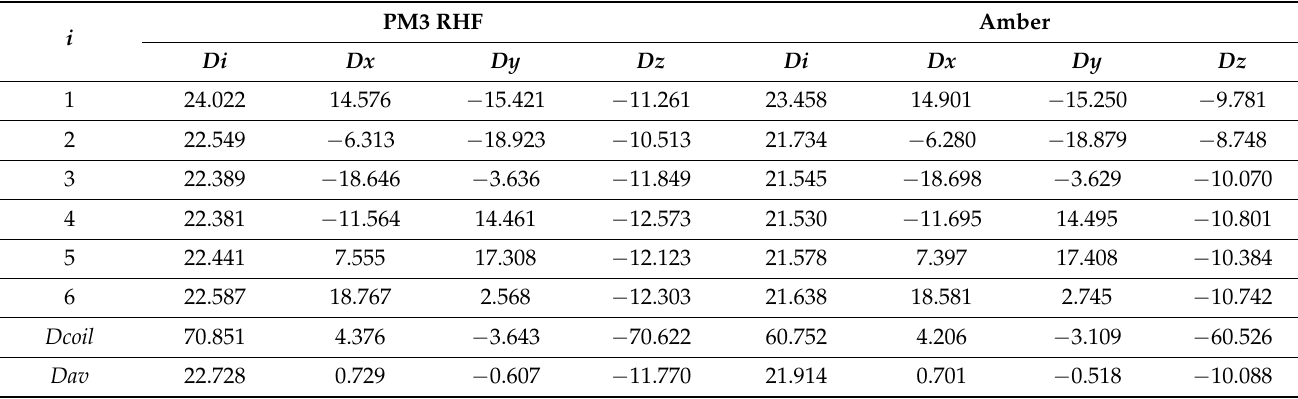
Table 3. Values of dipole moments for a coil of the helix-like L-FF PNT computed using PM3 (RHF) and Amber (after PM3) methods. All values of dipole moments are given in Debye